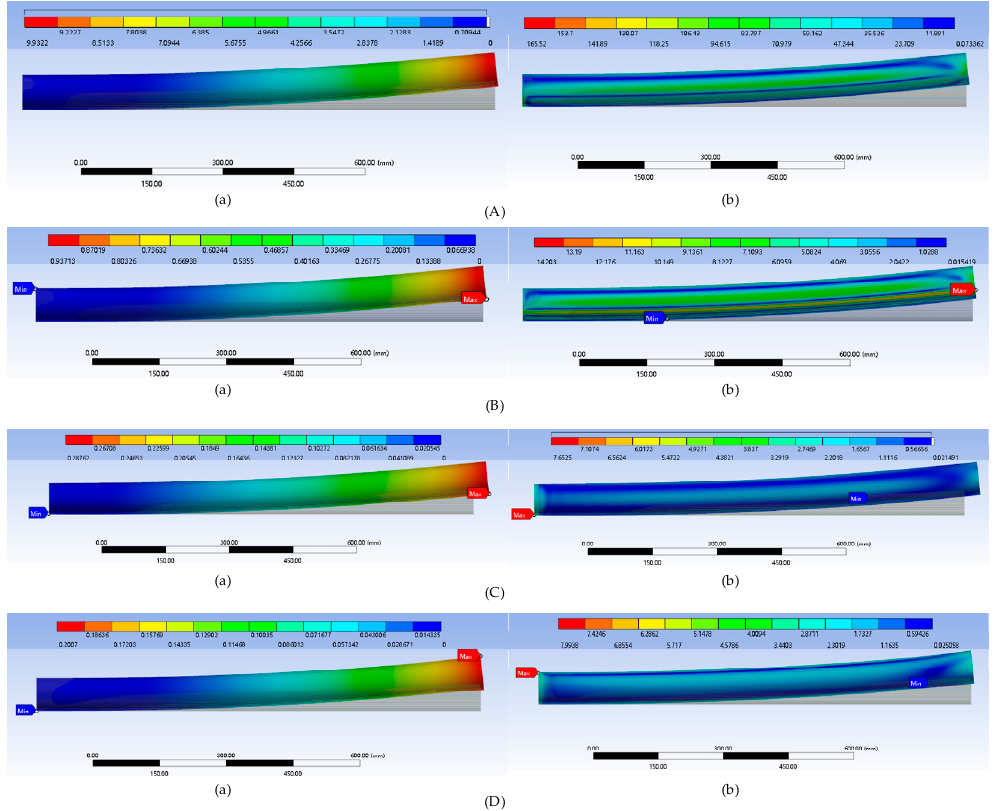
Figure 14. The steel absorber thermal deformation and equivalent stress of ( A ) the PTC, ( B ) the CPC, ( C ) the SUC and ( D ) the TTC in the SWH systems where ( a ) is the thermal deformation (Unit: mm), ( b ) is the equivalent stress (Unit: MPa). Note that the shadow in the figures are the location of the original tube receivers.